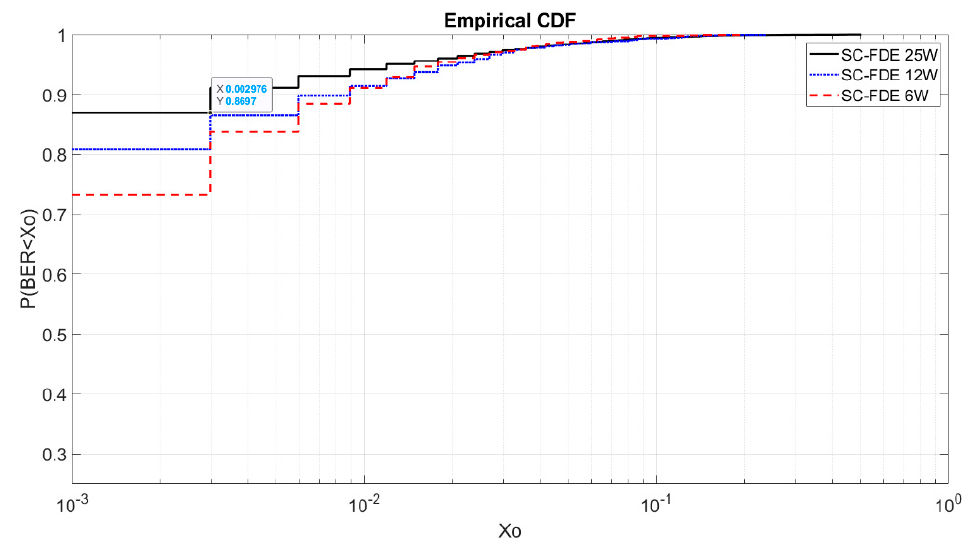
Figure 6. CDF plot of SC-FDE modulation with 6 W, 12 W, and 25 W of peak power.